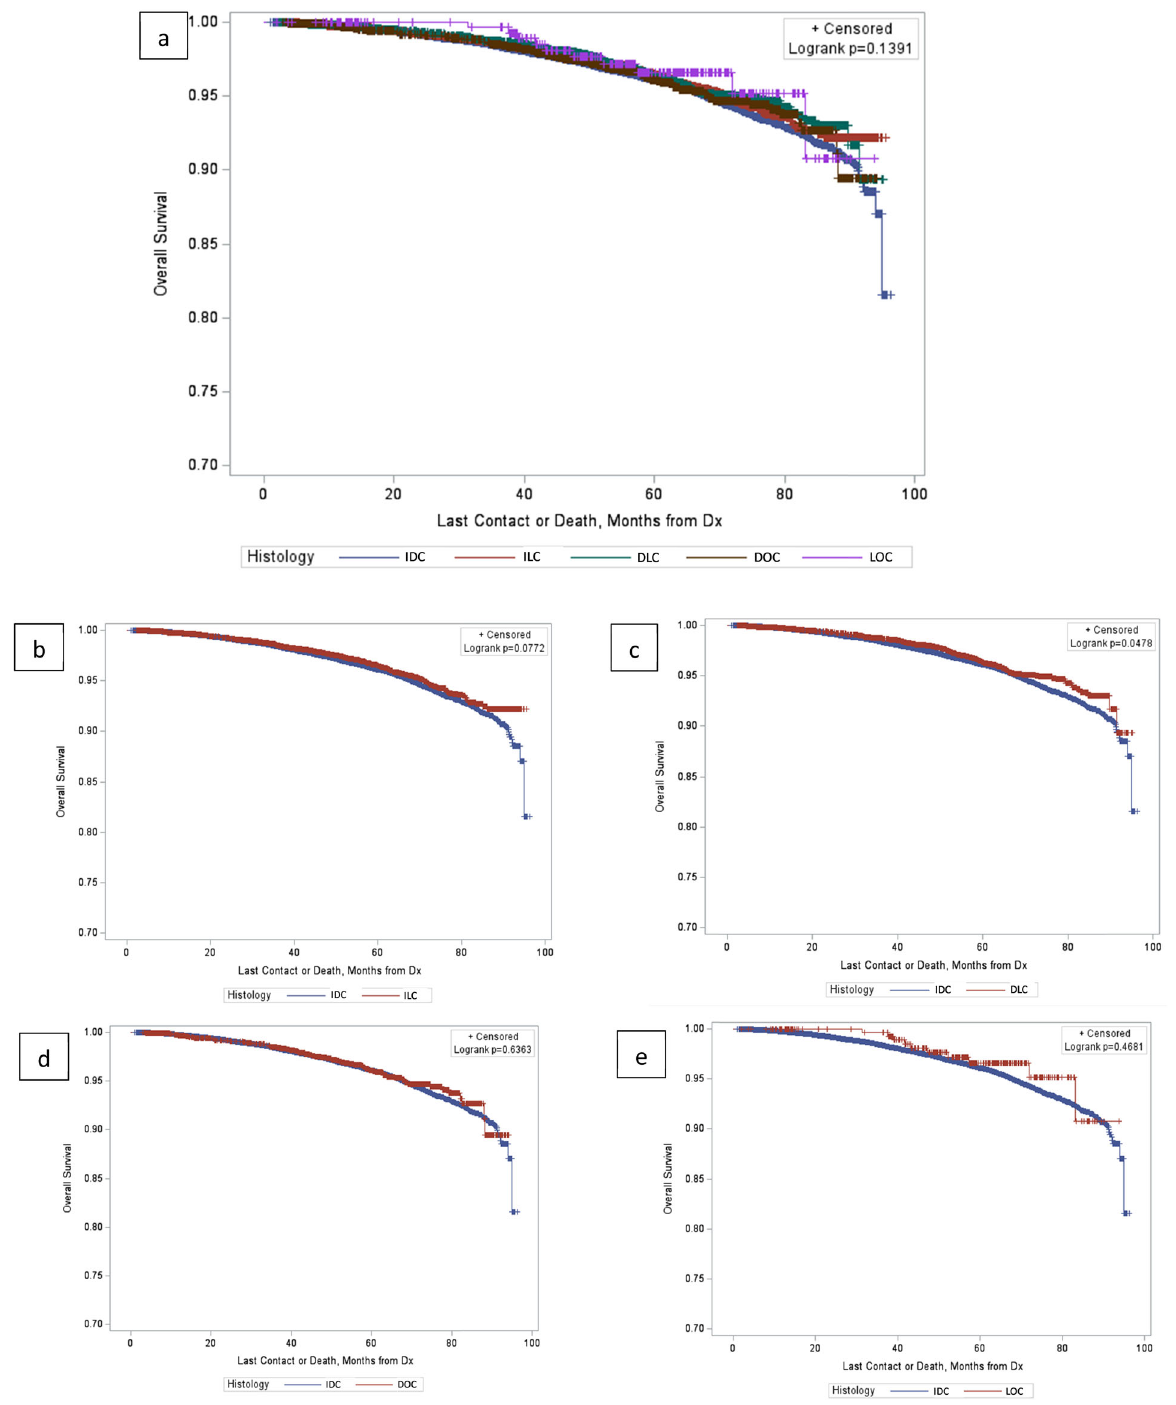
Fig. 4 Kaplan – Meier curve for OS in different histological subtypes. Kaplan – Meier curve for OS comparing different tumor histologic subtypes. ( a : all histologic subtypes, p = 0.1391; b : IDC vs ILC, p = 0.0772; c : IDC vs DLC, p = 0.0478; d : IDC vs DOC, p = 0.6363; e : IDC vs LOC, p =